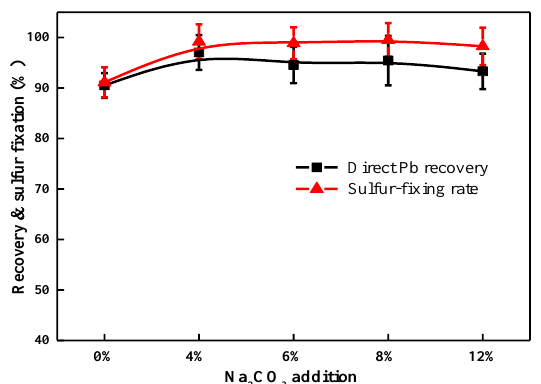
Figure 6. The effects of Na 2 CO 3 dosage on lead recovery and sulfur fixation. (W lead paste :W pyrite cinder :W coke = 200:50:24 g, FeO/SiO 2 = 1.3, CaO/SiO 2 = 0.4, 1200 °C, 2 h).